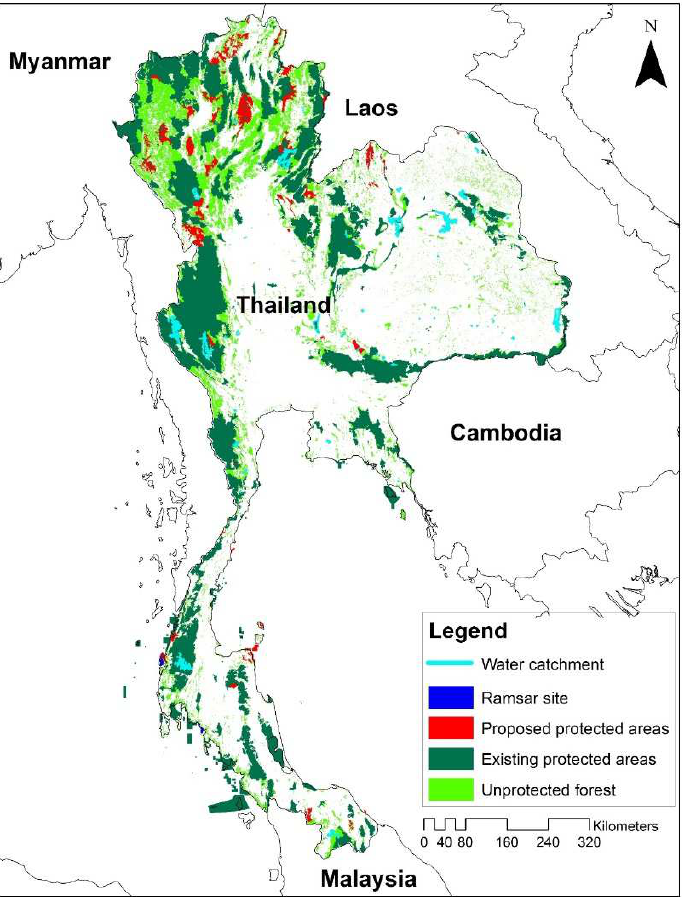
Figure 1. Thailand: Existing and proposed protected areas, water catchments, Ramsar sites, and unprotected forest. Shapefiles from the Department of National Parks, Wildlife and Plant Conser- vation (protected areas), the Royal Forest Department (forest), Royal Irrigation Department (water catchments), UNEP-WCMC (Ramsar sites) [14].